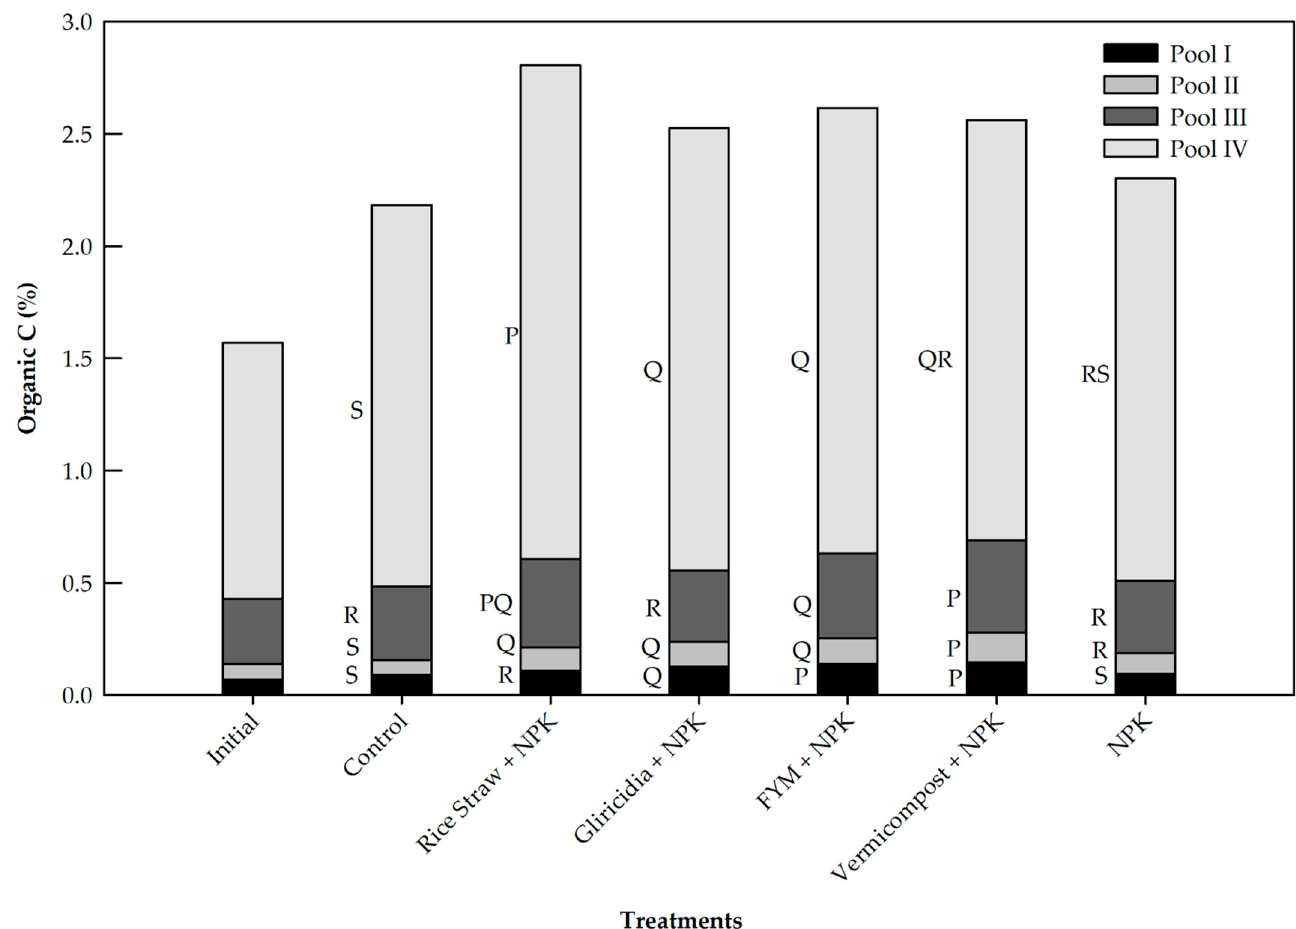
Figure 3. Effects of treatments on different pools of organic carbon extracted based on oxidizability (pool-I, pool-II, pool-III and pool-IV). The values are the averages over three crop growth stages through three consecutive crop growing seasons. Bars followed by the same letter are not significantly different at p < 0.05.